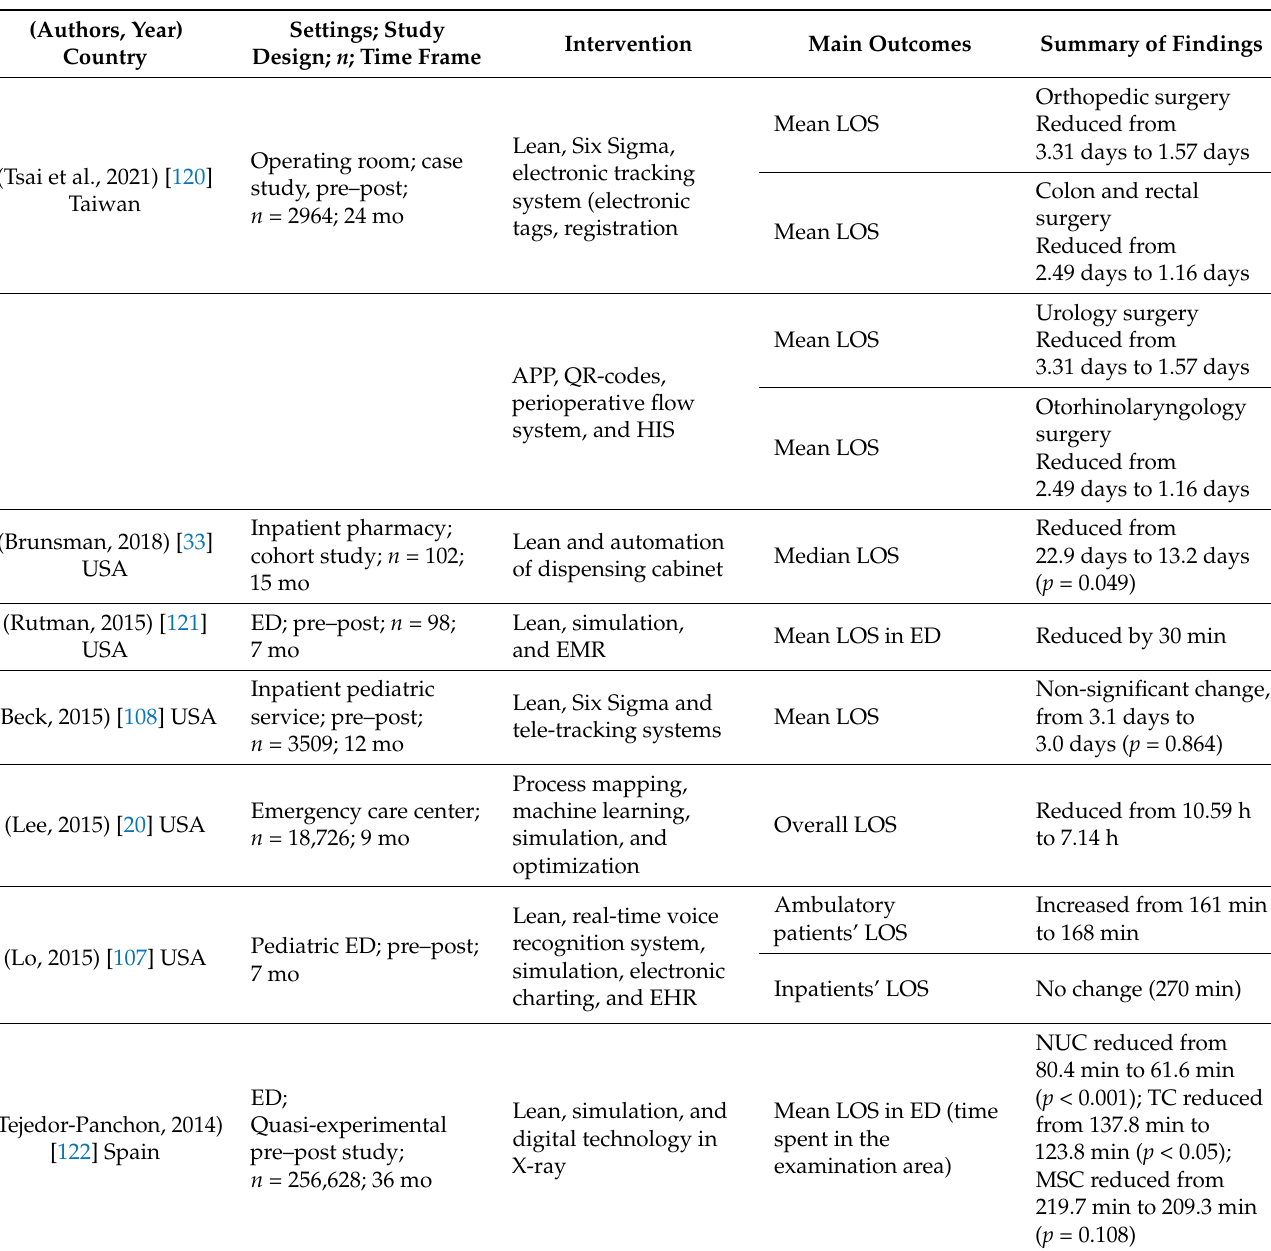
Table 3. LOS outcomes of LH interventions supported by